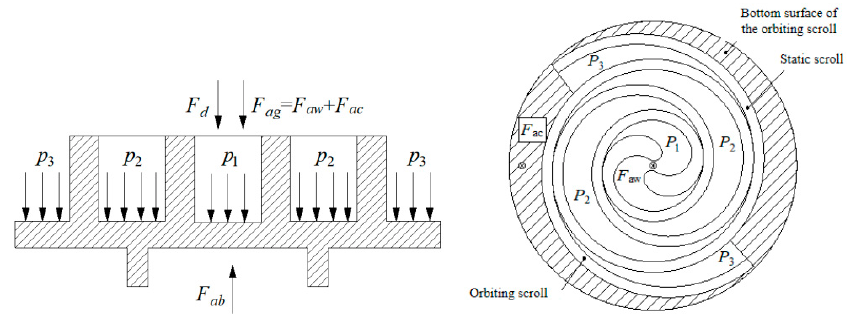
Figure 1. The schematic diagram of the axial force balance.